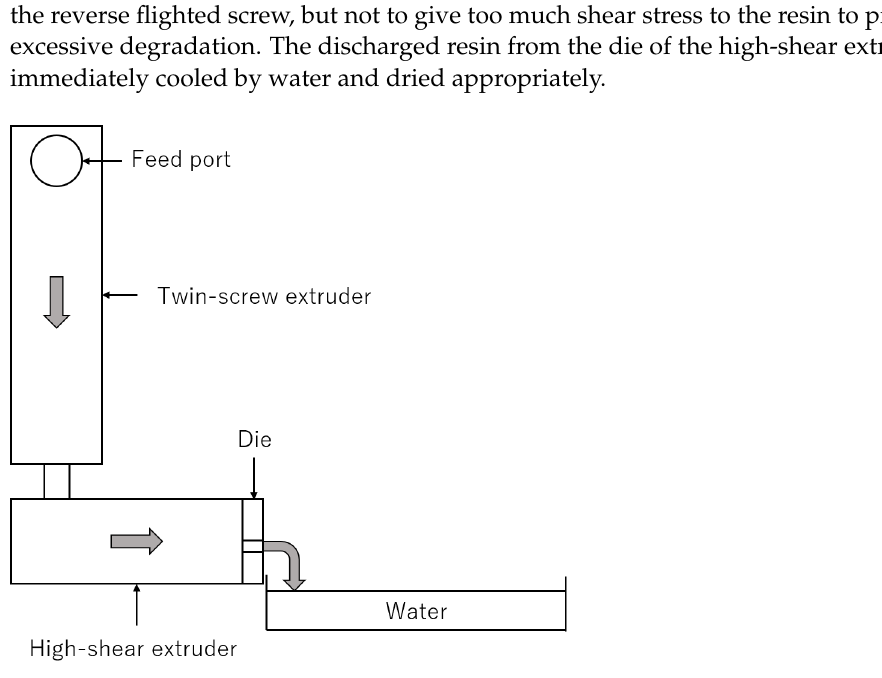
Figure 3. Total system of our experiments. The twin-screw extruder and the high-shear extruder were connected by a circular single tube with the diameter of 10 mm and the length of 150 mm. The resin was feeded from the feed port, and flows in the twin-screw extruder, followed by the high-shear